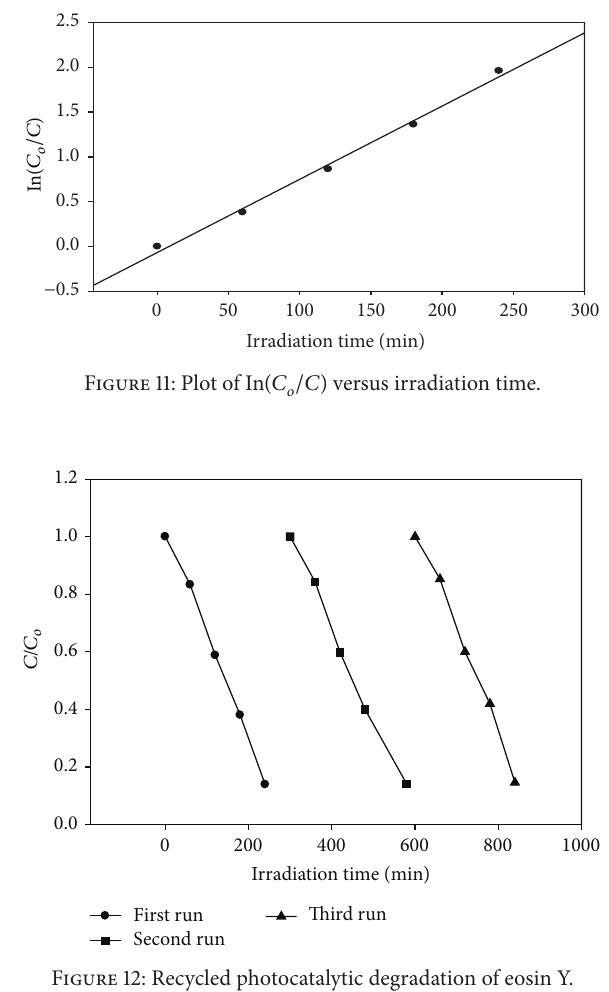
suggested that the UV/Ag-Fe 3 O 4 system could be used as a useful technique for the removal of harmful dyes from indus- trial wastewater. Work is currently investigating different azo dyes using the fabricated Ag-MNPs